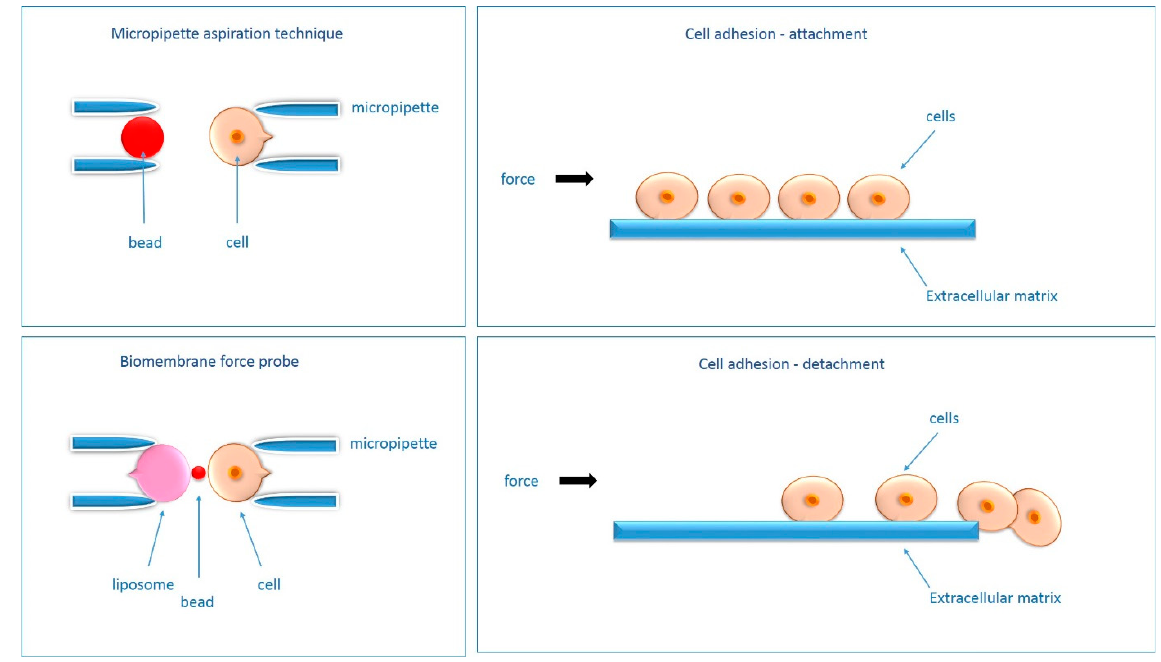
Figure 4. Schematic of selected methods of adhesion detection (micropipette aspiration technique, bio-plasma force probe), including the mechanism of cell attachment and detachment-overview figure. A detailed description of the methods presented can be found in [62,63].